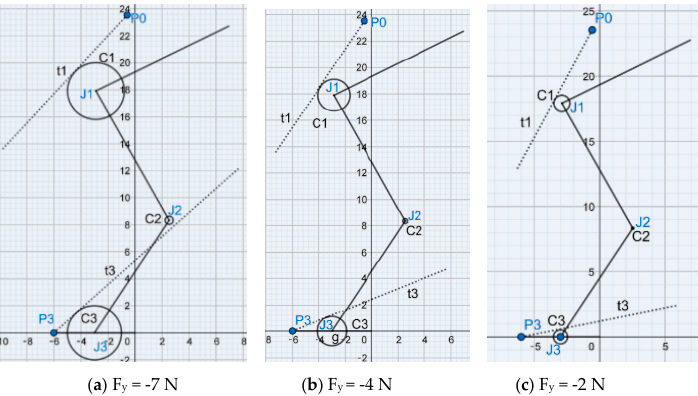
Figure 6. Circle Ci and tangential line l i depending on the vertical force, F y , and tensional force, T (T is fixed as 10 N). ( a ) F y = ‐ 7 N; ( b ) F y = ‐ 4 N; ( c ) F y = ‐ 2 N.